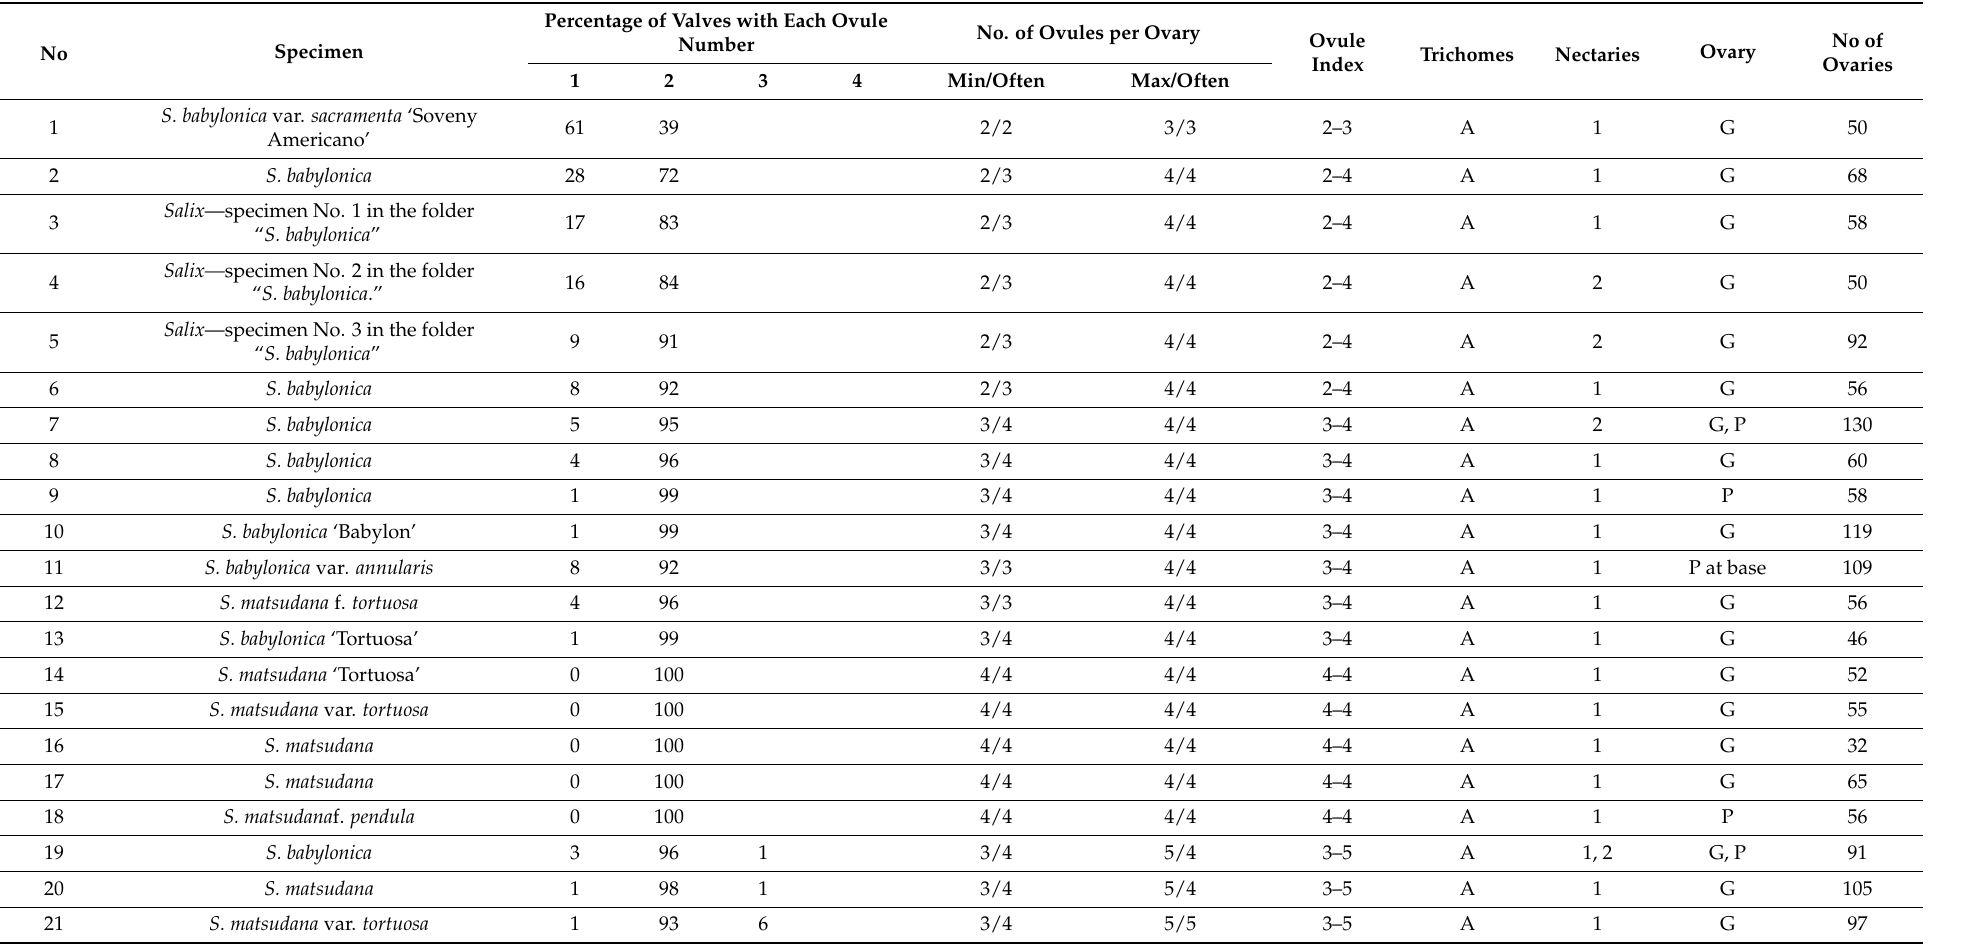
Table 1. The ovule data for S. babylonica . Each capsule in Salix has 2 valves and the presented data include the percentage of valves in a catkin with different numbers of ovules. Additional characteristics are included: the number of ovules per ovary (min/often and max/often), the ovule indices (the minimum and maximum number of ovules per ovary), presence of trichomes at bract apex (A—bracts abscised; N—none; L—long; S—short), number of nectaries, ovary pubescence (G—glabrous; P—pubescent) and number of studied